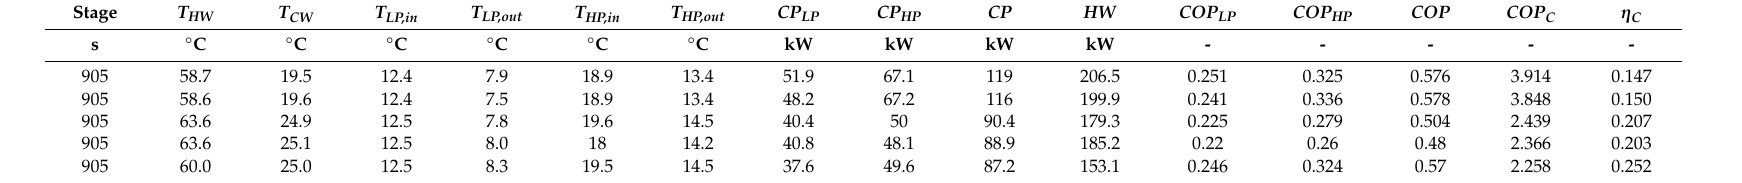
Table 5. Results of 5 measurements with the highest cooling power (original control system).